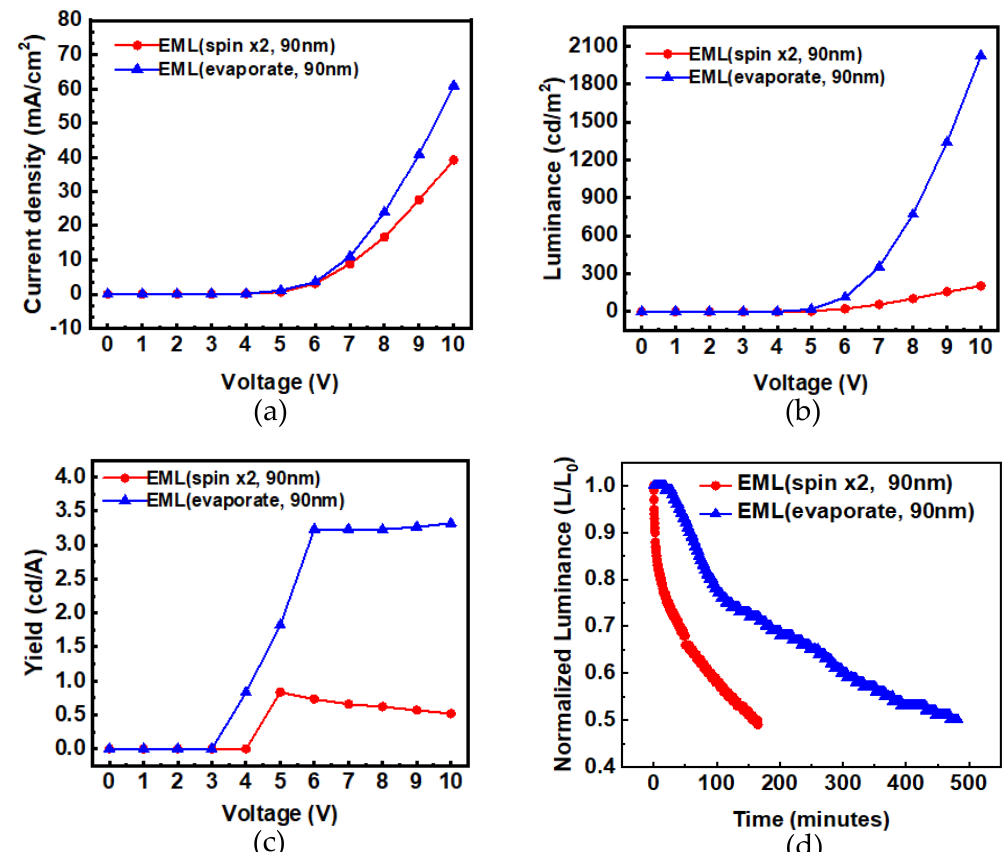
Figure 5. Comparisons of ( a ) I − V, ( b ) L − V, ( c ) η− V, and ( d ) lifetime characteristics of spin-coated EML compared with vacuum-evaporated.